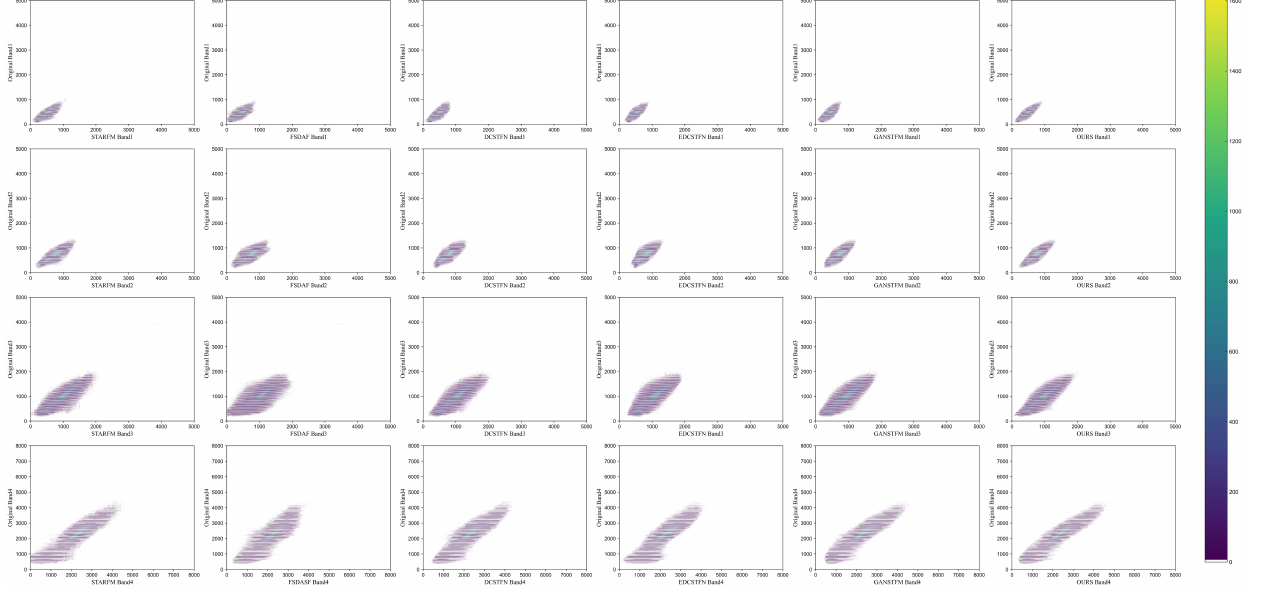
Figure 10. Thermal scattering results for the CIA dataset. (Each column corresponds to the compari- son of each band. The abscissa is the band of the predicted image, and the ordinate is the band of the real